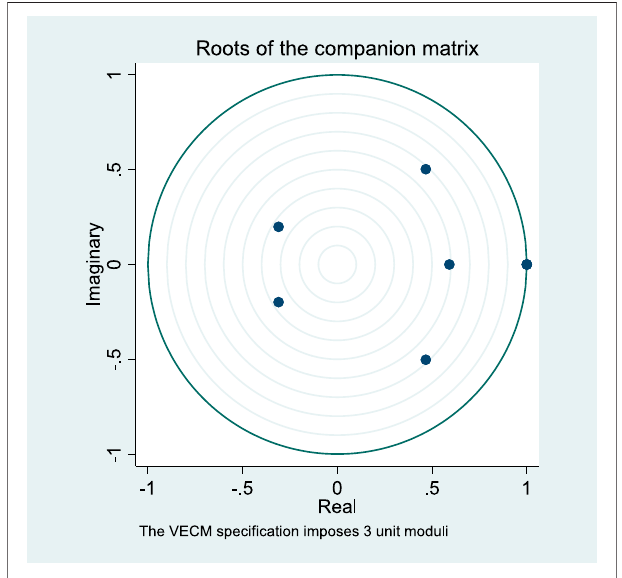
FIGURE 5 | System stability discrimination diagram of the vector error correction model. Source: Authors.